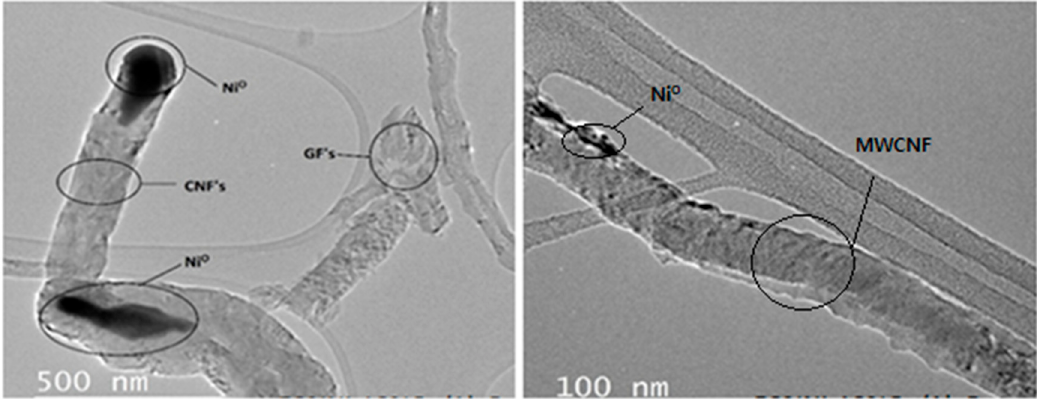
Figure 7. TEM images of carbon deposited on the